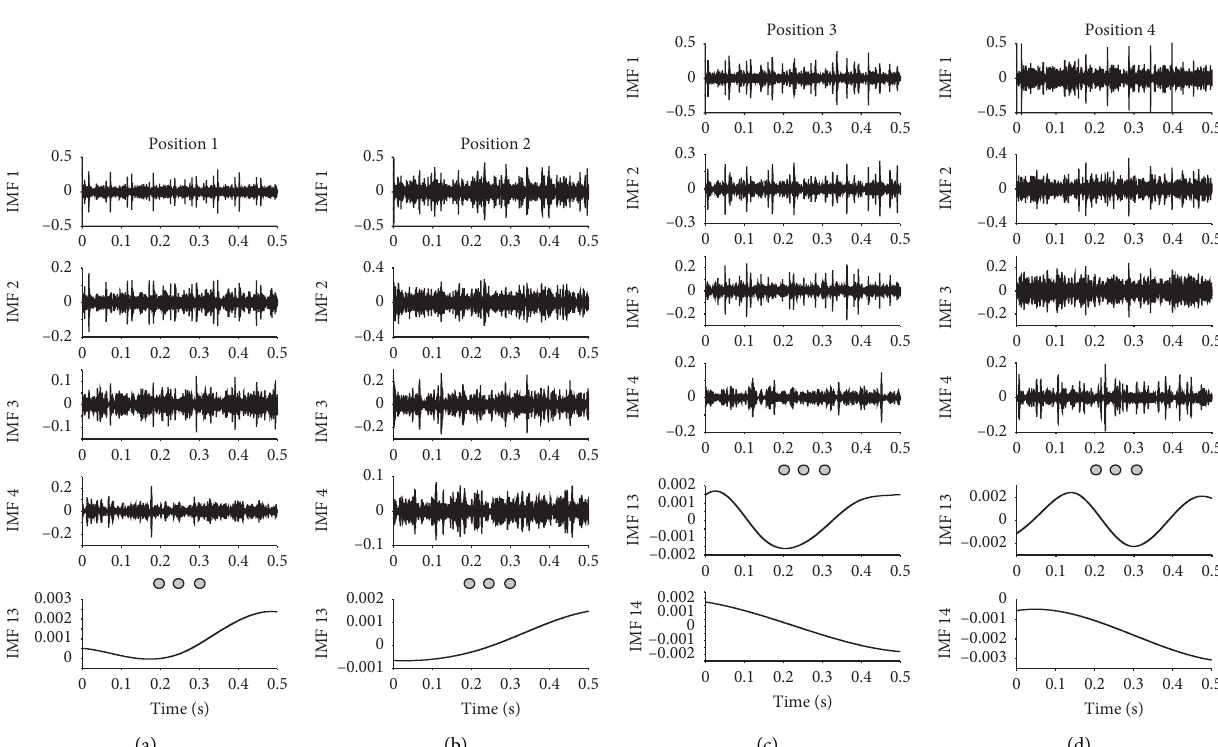
Figure 8: Decomposition result of multivariate signal using EMD (normal